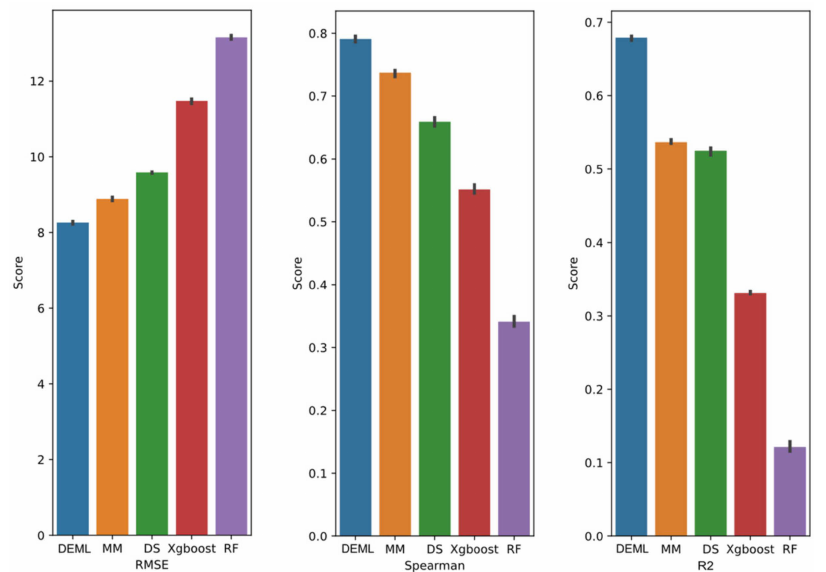
Figure 2. Regression prediction performance of DEML and single-task comparison algorithms in Loewe regression prediction task. The error bar represents 95% confidence interval of five-fold